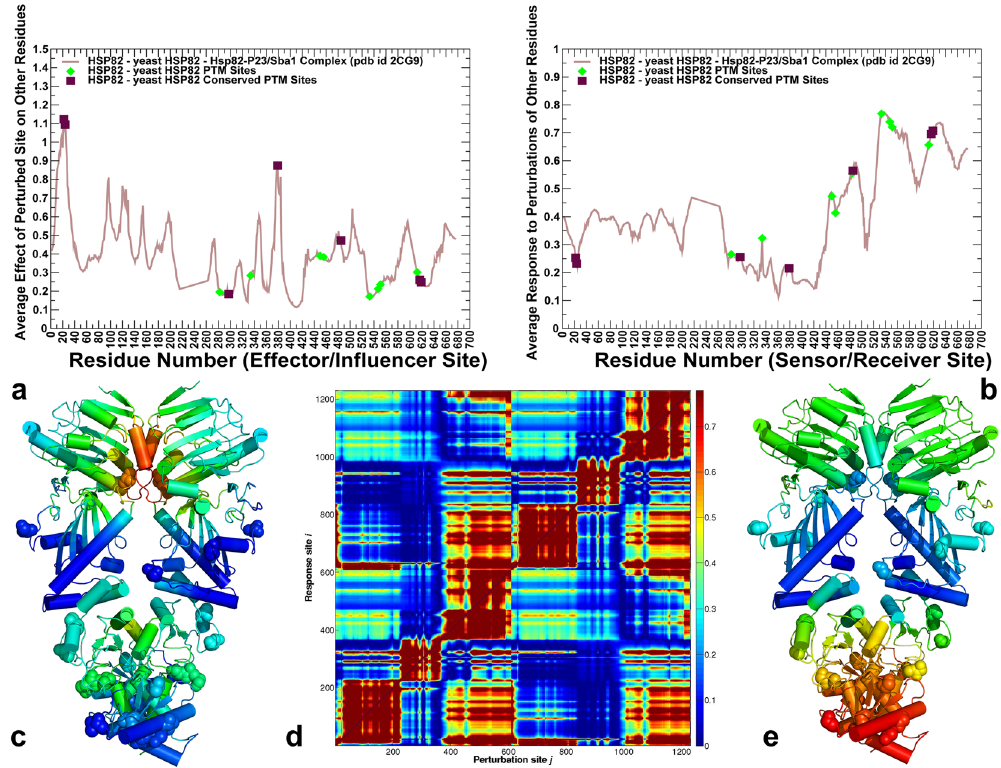
Figure 7. The PRS Analysis of the yeast Hsp82 Identifies Effector and Sensor Sites of Allosteric Signaling. ( a ) The residue-based effector profile measures the average impact of the perturbed site on all other residues in the Hsp82 dimer structure. The effector profile value for a given residue is the average over all elements of the PRS matrix in the corresponding row. This parameter quantifies the average residue propensity to transmit perturbation. ( b ) The residue-based sensor profile measures the average response of a given residue to perturbations of all other residues in the Hsp82 dimer. The sensor profile value for a given residue is the average over all elements of the PRS matrix in the corresponding column. This metric estimates the average residue propensity to sense perturbations of other residues. In panels (a,b) the effector/sensor parameter values for PTM sites are highlighted as green filled diamonds, and for conserved PTM sites in filled maroon squares. ( c ) The crystal structure is color-coded by ability to propagate perturbations, where red regions are strongest effectors. ( d ) The normalized PRS heat map where the strongest signals of high sensor/effector residues are shown in dark red. ( e ) The crystal structure of yeast Hsp82 is color-coded by sensitivity to perturbation. Red/ orange regions are the most susceptible sensor sites, while dark-blue regions are the most insensitive sites; green/cyan regions show moderate sensitivity to